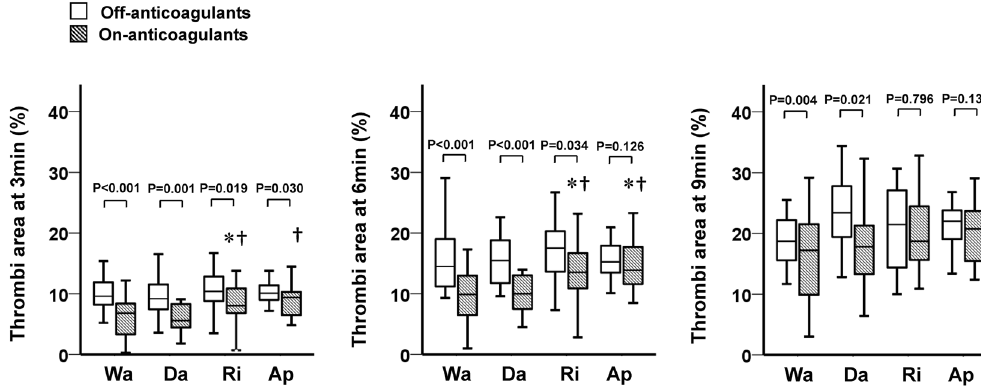
Figure 5. Thrombi area computed from analysis of the AR chip induced by various anticoagulants. In these box-and-whisker plots, lines within the boxes represent median values; the upper and lower lines of the boxes represent the 25th and 75th percentiles, respectively; and the upper and lower bars outside the boxes represent maximum and minimum values, respectively. * Adjusted P < 0.05 vs. warfarin at On-anticoagulants; significance probability was adjusted for Bonferroni method. †Adjusted P < 0.05 vs. dabigatran at On- anticoagulants; significance probability was adjusted for Bonferroni method. Wa = warfarin, Da = dabigatran, Ri = rivaroxaban, Ap =